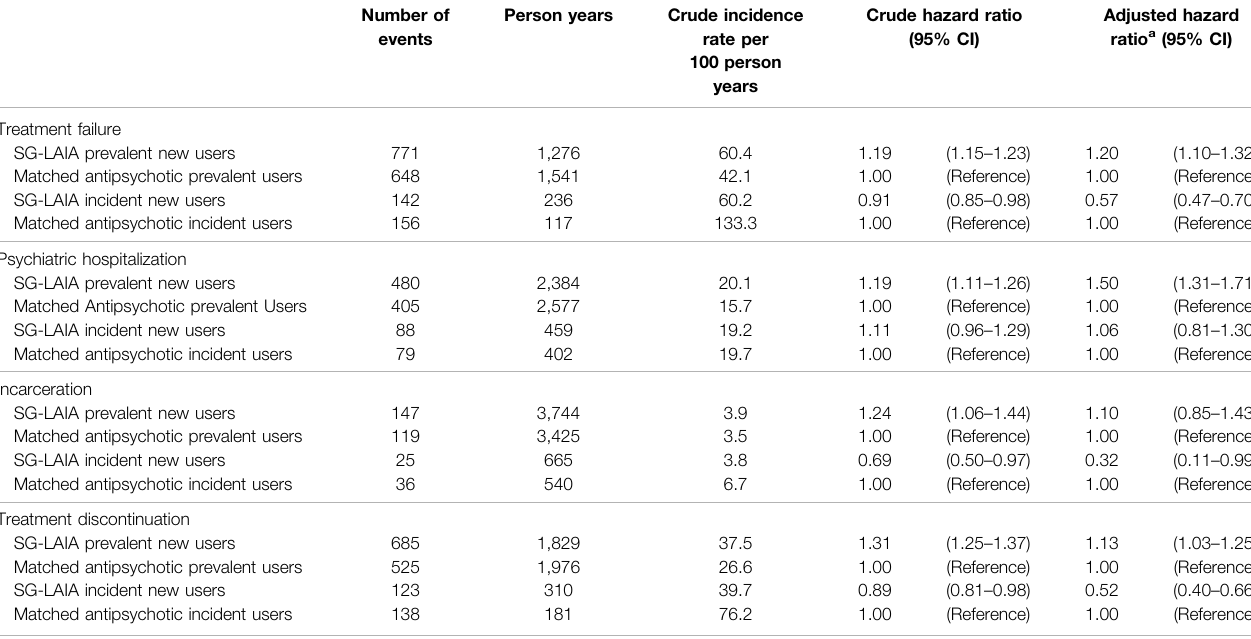
TABLE 4 | Association between second-generation long-acting injectable antipsychotics versus oral antipsychotics and treatment failure, psychiatric hospitalization, incarceration, treatment discontinuation, and all-cause mortality in prevalent and incident new